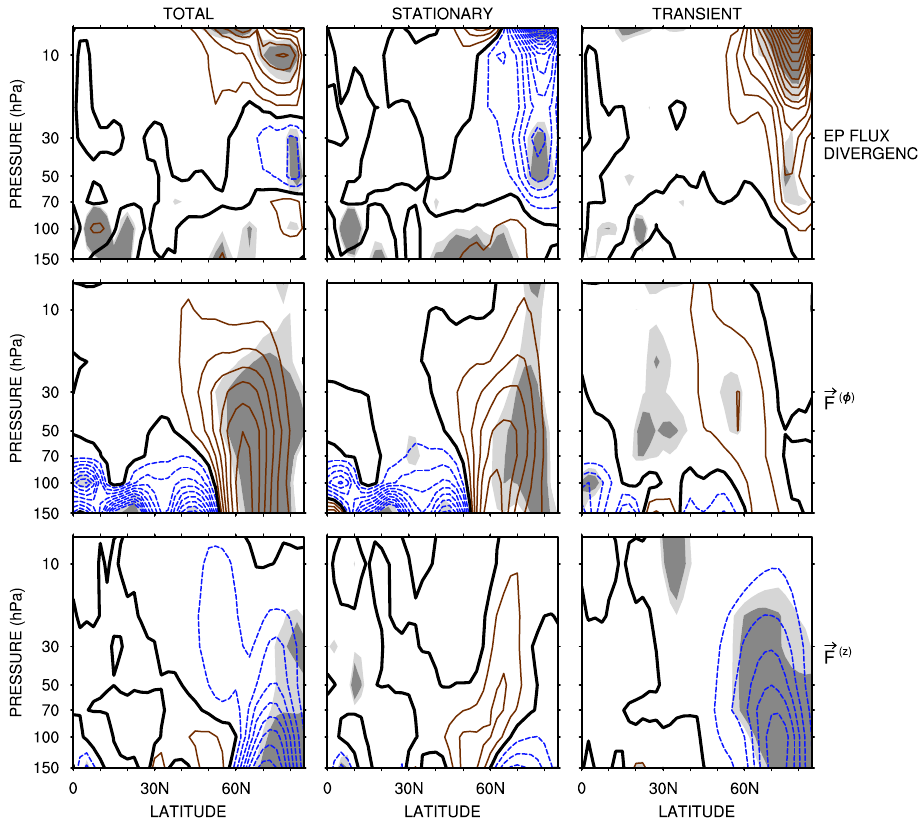
Fig. 11. Same as Fig. 10 but for the month of February in the NH. Contour interval is 0.5ms − 1 day − 1 per decade for the EP flux divergence, 5 × 10 5 kgs − 2 per decade for F (φ) and 5 × 10 3 kgs − 2 per decade for F (z)